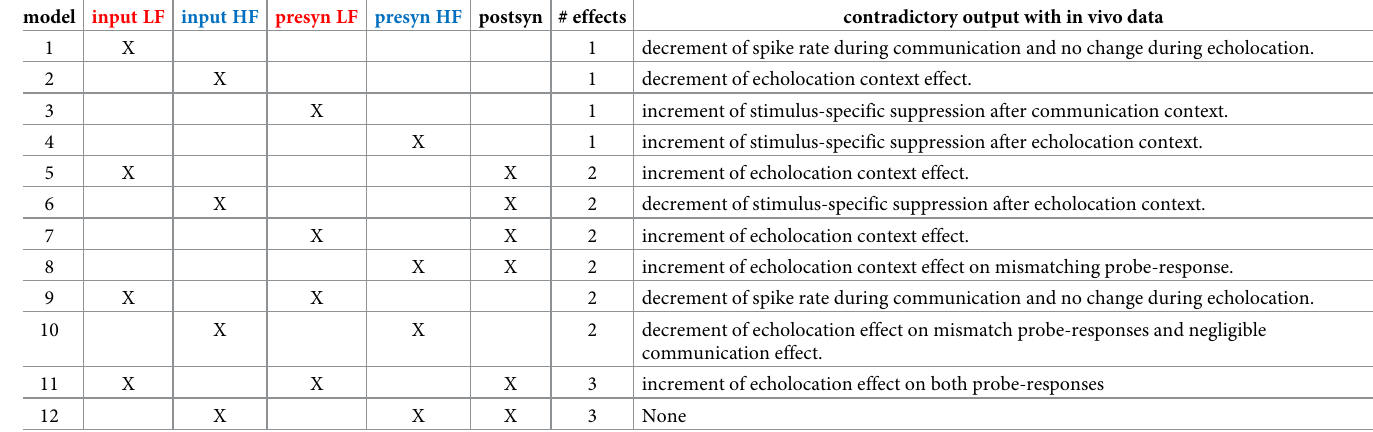
Table 1. Qualitative comparison between multiple models of frequency-specific anaesthesia effect and data obtained in vivo. In all models, anaesthesia effects were associated with either HF tuned inputs or LF tuned inputs, but never to both. Frequency-specific effects were implemented as a decrease of the cortical input firing rate (“input”) or an increase of presynaptic adaptation (“presyn”), either one of them (1 to 8) or both (9 to 12). In addition, some of the models can include an increment of postsynaptic adaptation (“postsyn”), which is not frequency specific (5 to 8 and 11 to